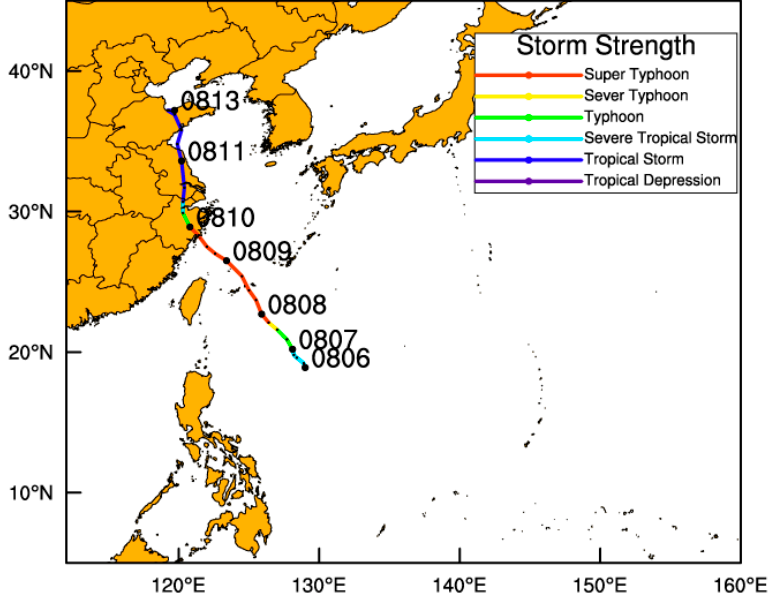
Figure 1. The moving track and strength change of super typhoon Lekima from 6 August to 13 August 2019.